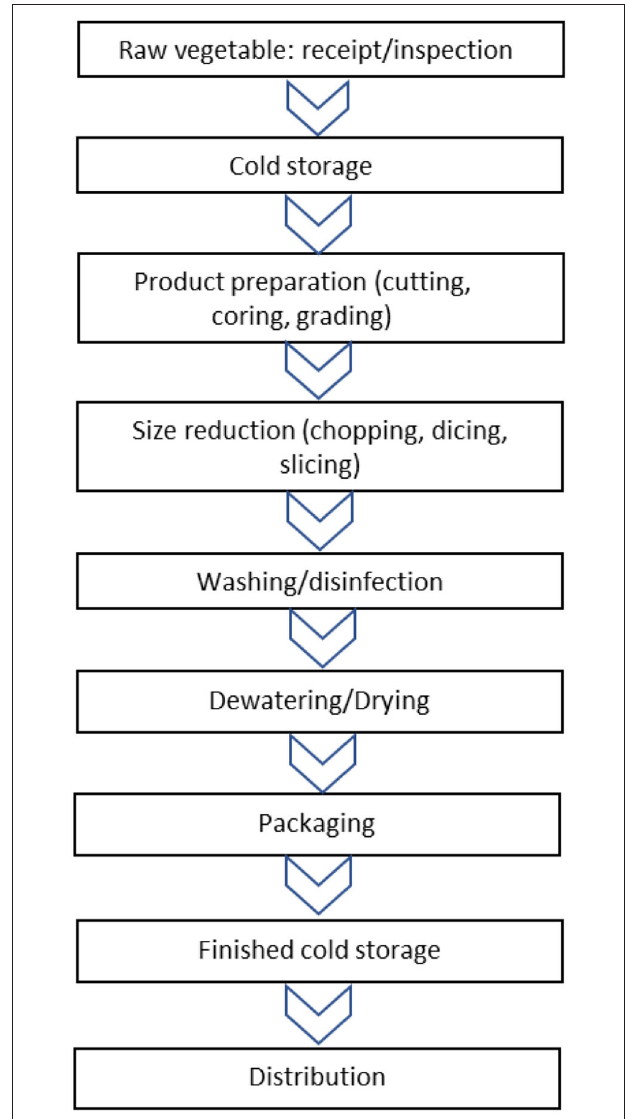
FIGURE 1 | Product flow diagram in a typical fresh-cut vegetables production